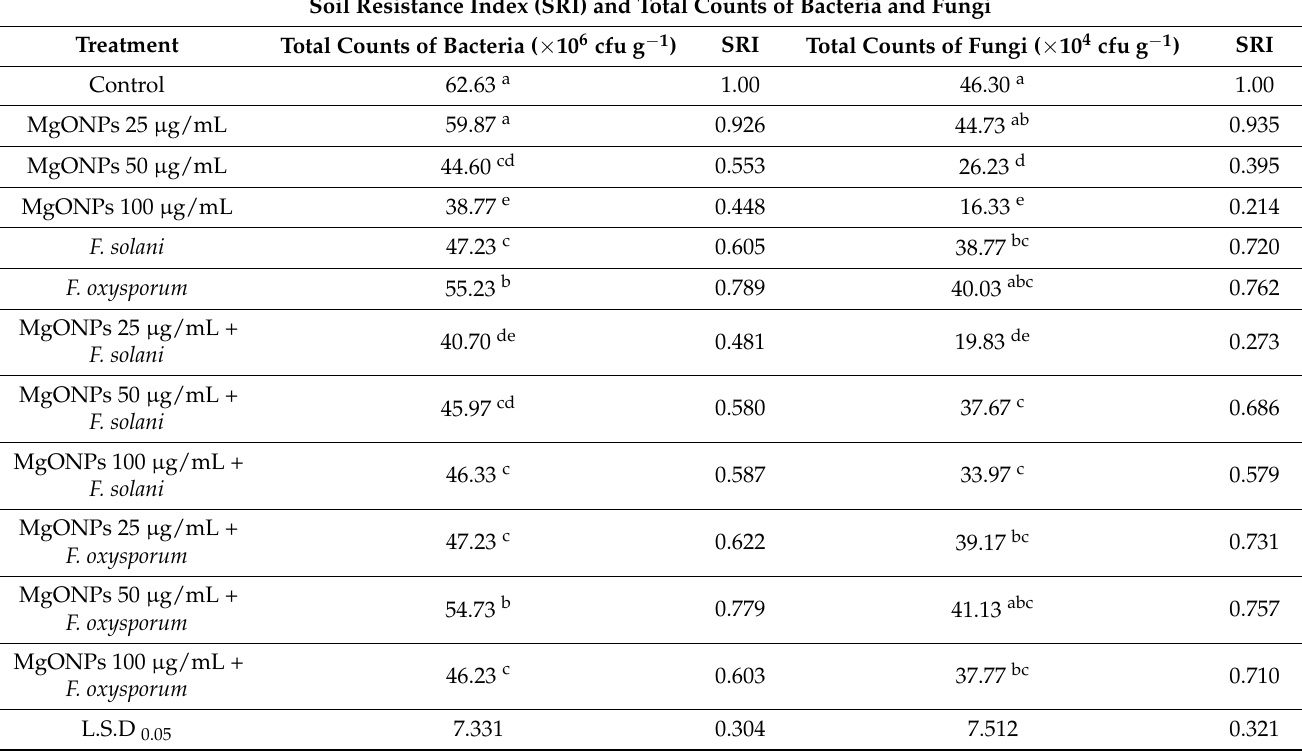
Table 2. Totalcountsofbacteriaandfungiandthesoilresistanceindex(SRI)asimpactedbydifferenttreatments. Soil Resistance Index (SRI) and Total Counts of Bacteria and Fungi